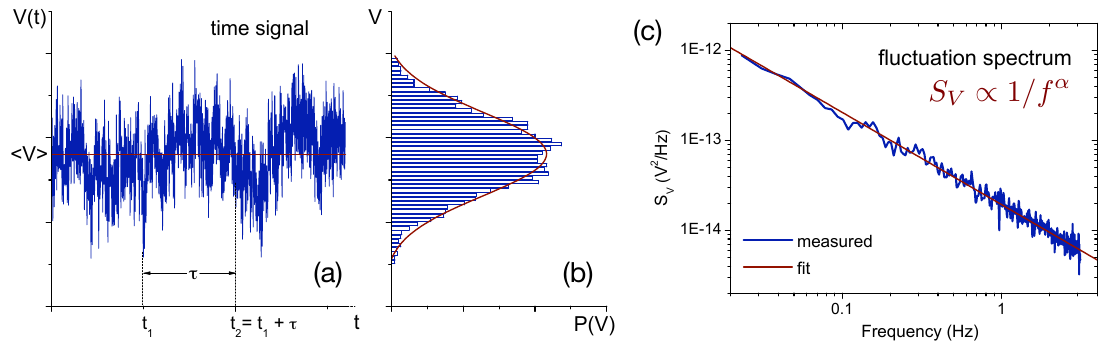
Figure 3. Schematics of a voltage (resistance) noise measurement. ( a ) time-train of the voltage signal and ( b ) histogram of the voltage distribution fitted by a Gaussian function; ( c ) noise power spectral density (PSD) of the signal in ( a ) fitted by a power law with frequency exponent α permission from [9]. Copyright (2011) John Wiley and